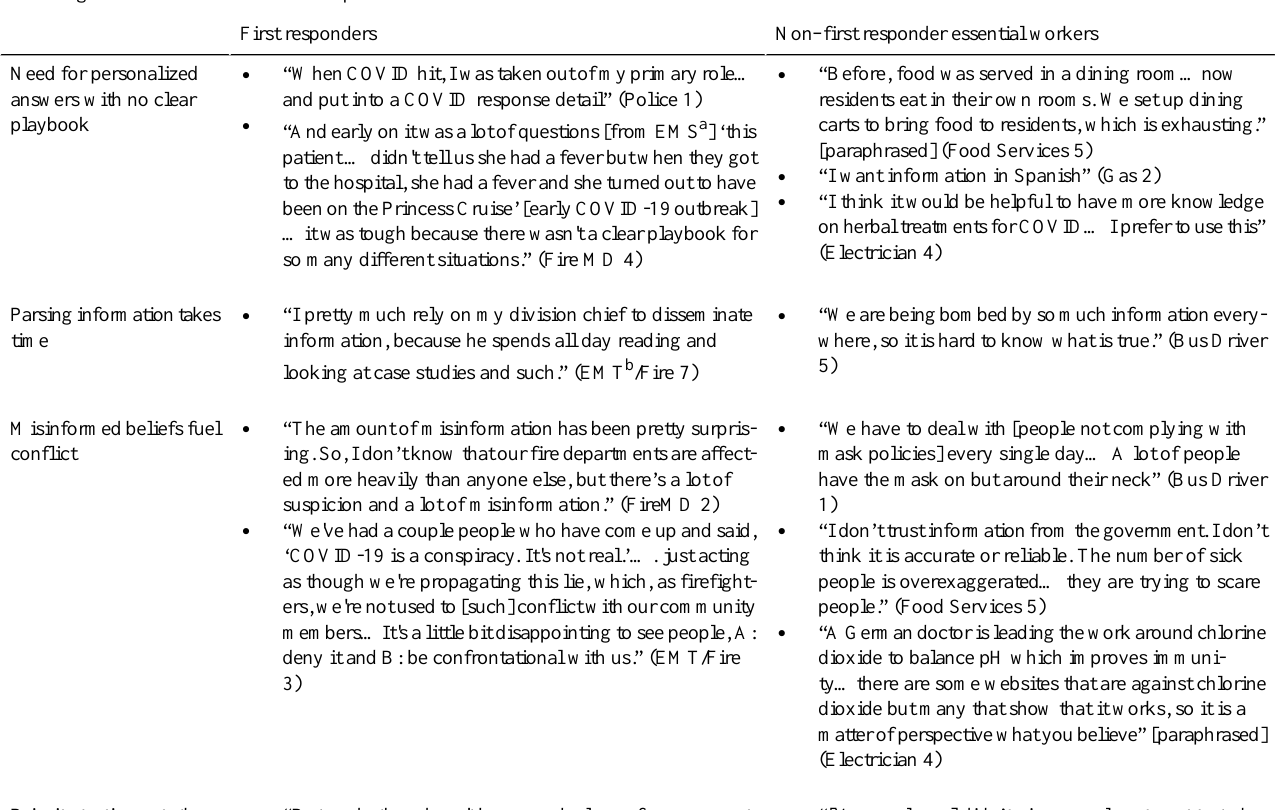
Table 2. Impact of the COVID-19 pandemic on first responders and essential workers. Illustrative